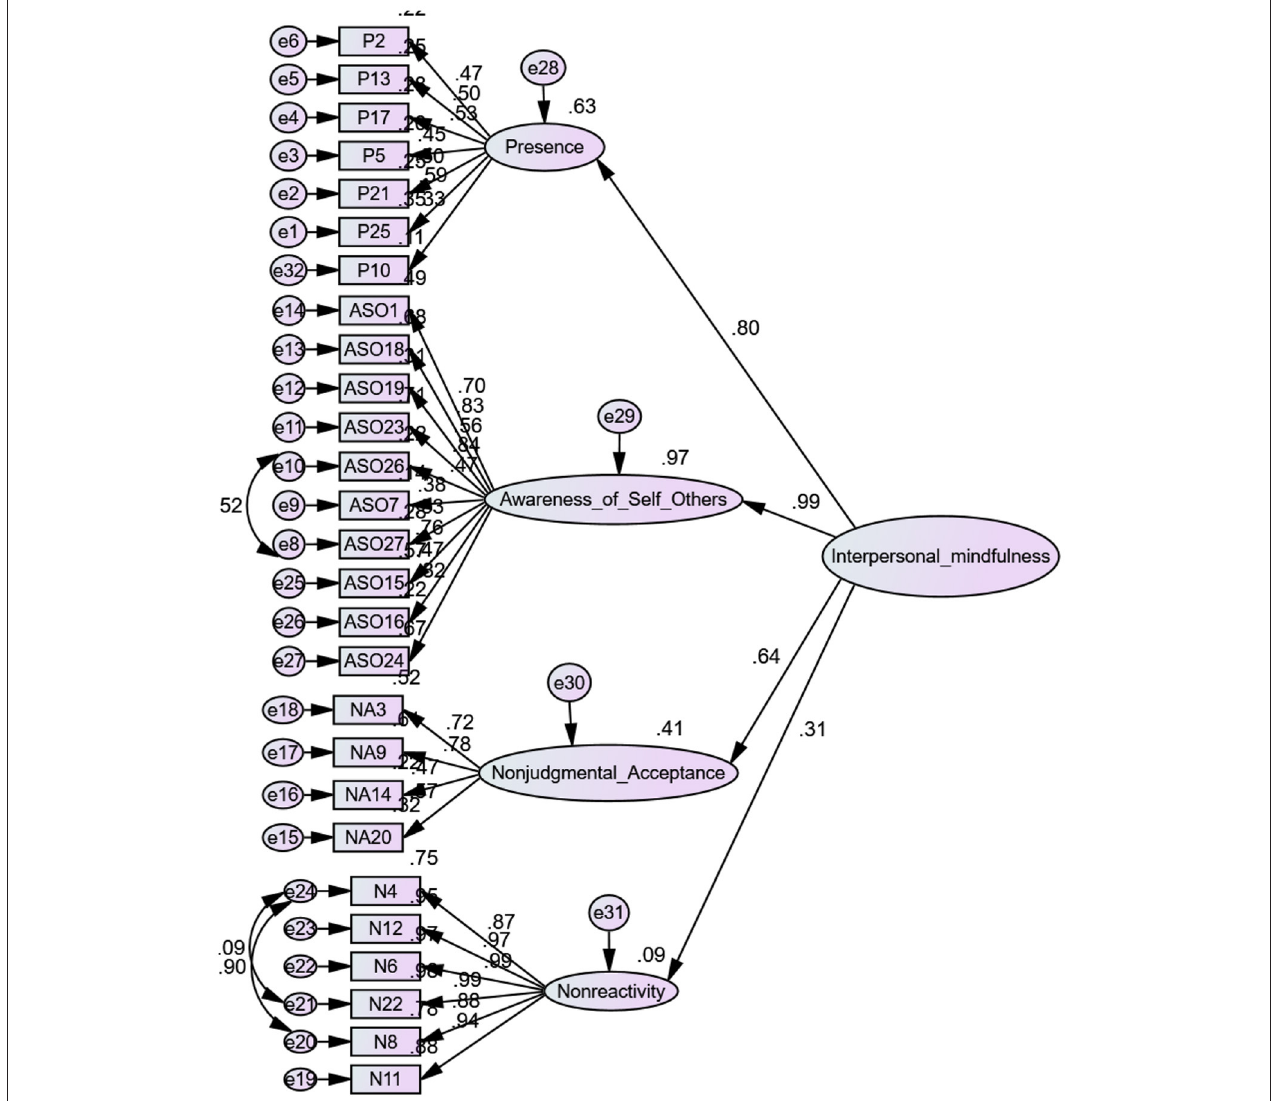
FIGURE 1 | Confirmatory factor analysis with factor loadings for the four sub scales of IMS scale ( p < 0.01).